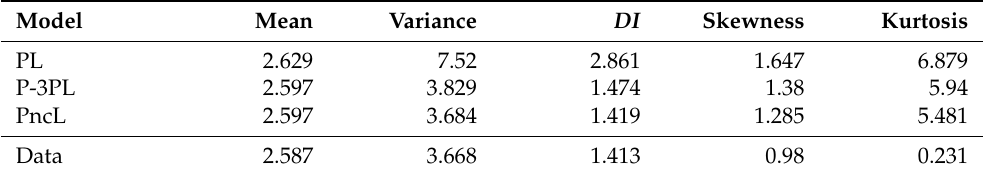
Table 5. Mean, variance, DI , skewness, and kurtosis values of considered discrete models for the psychiatric dataset.